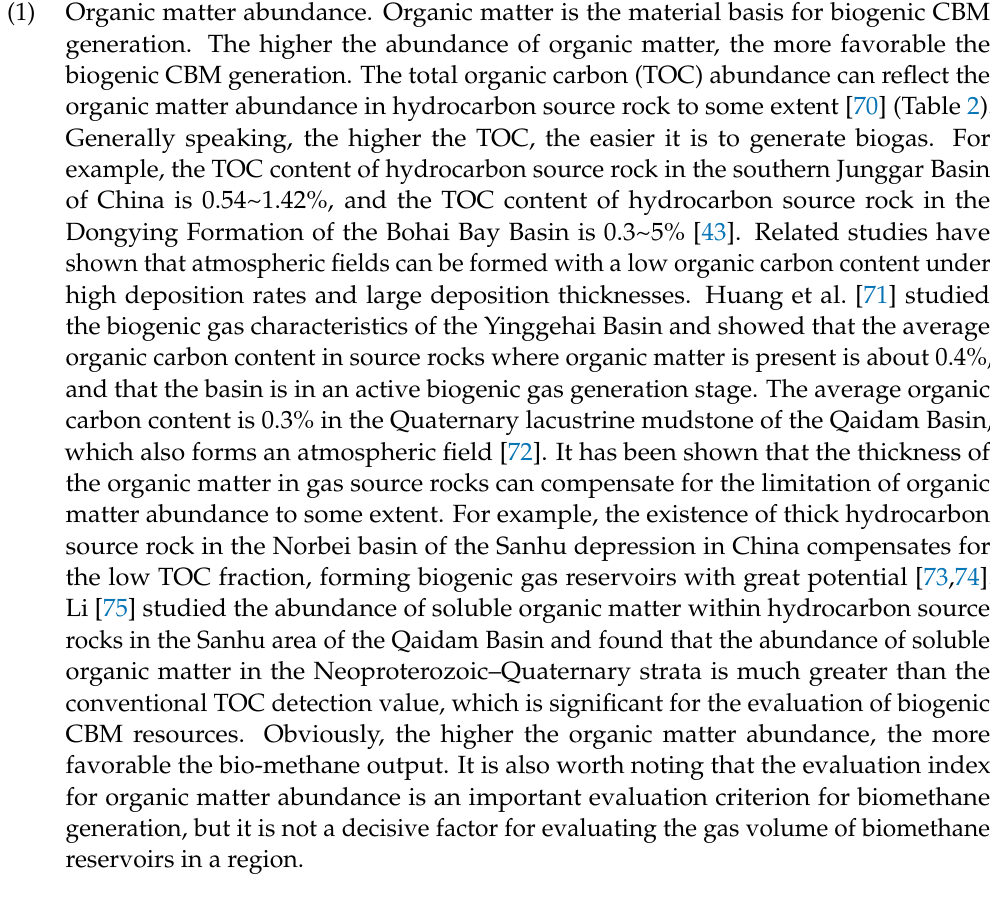
Table 2. Biologic gas source rock evaluation table